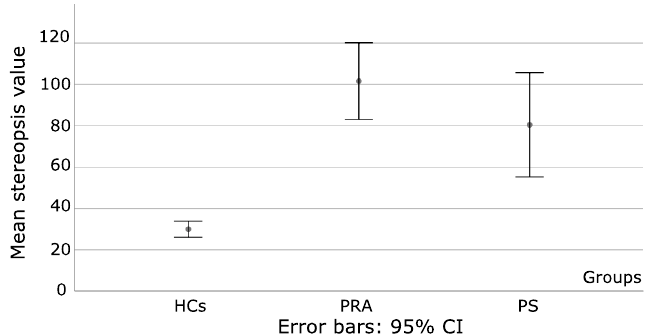
Figure 2. Illustrates the mean values of stereopsis and s.d for each group. PS and PRA present similar degrees of stereopsis (gross stereopsis), but with greater heterogeneity for the obtained values for PS, as shown by the s.d. HCs, which show fine stereopsis, and that allow us to visualize the significant differences between healthy controls and patients with strabismus and